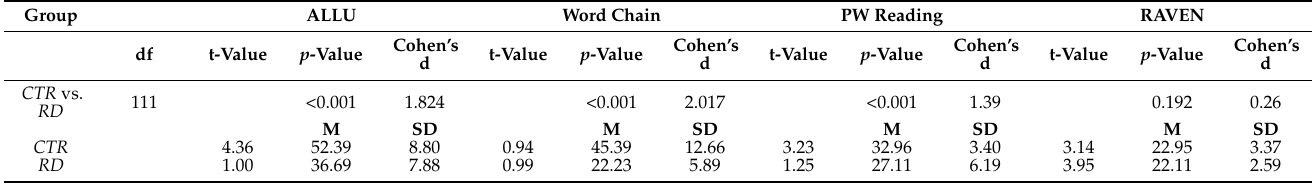
Table 1. Summary of the three reading tests (ALLU, Word Chain reading and Pseudoword reading) and the Raven’s Standard Progressive Matrice test for the CTR and the RD